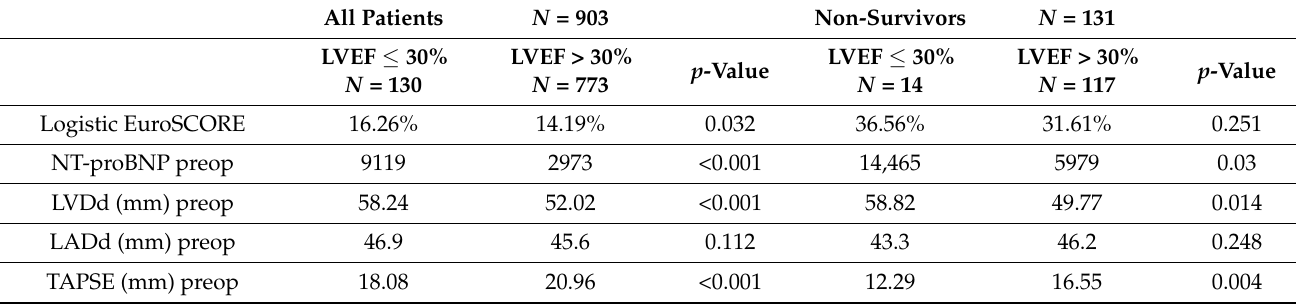
Table 4. Risk profile and relation to mortality in patients with LVEF ≤ 30% and >30% before propensity score